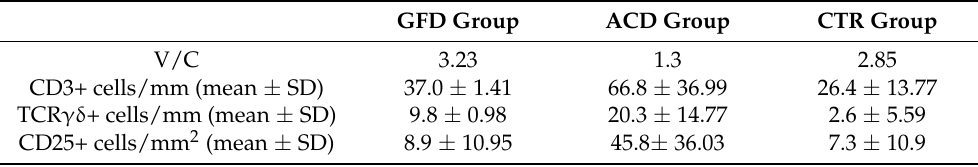
Table 2. Histological and Immunohistochemical features.